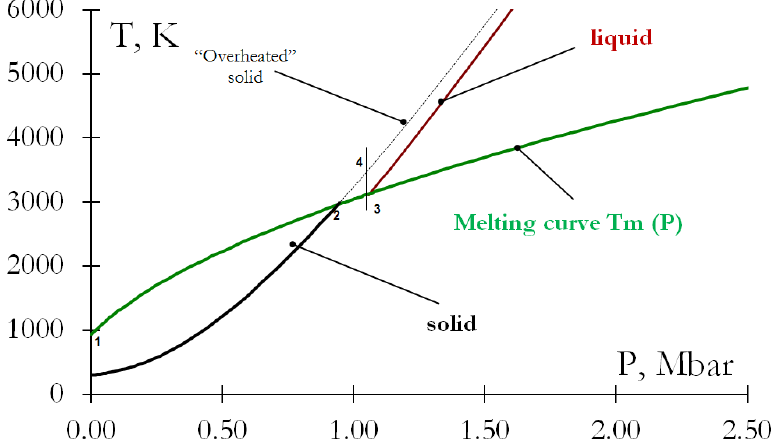
Figure 3: Melting curve and shock adiabats in the domains of the solid and liquid